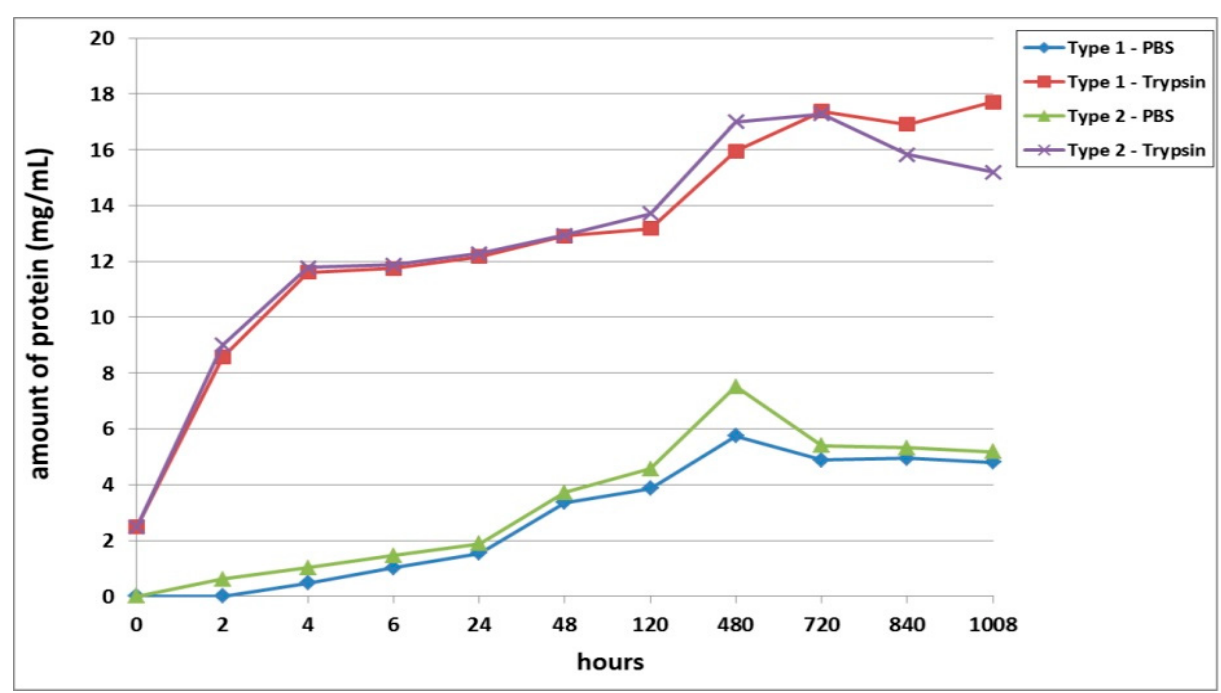
Figure 1. Passive and enzymatic biodegradation of cell-free scaffolds. Note: PBS—passive biodegradation of scaffolds in PBS solution; Trypsin—enzymatic biodegradation of scaffolds in a solution of the hydrolytic enzyme trypsin.